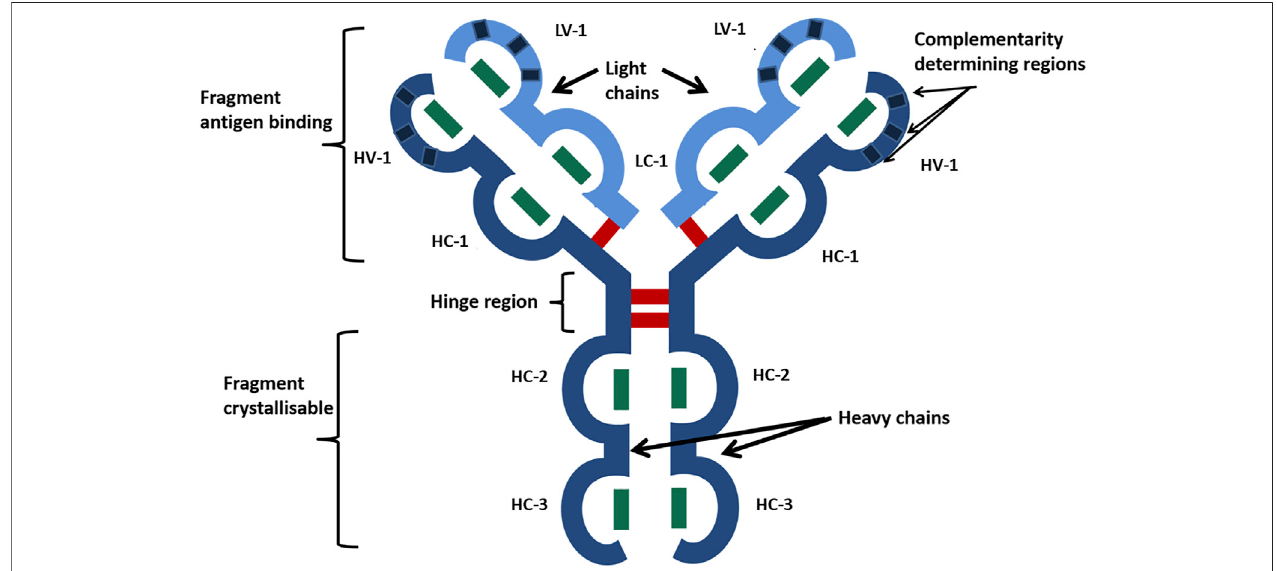
FIGURE 1 | Schematic of the IgG1 mAb characteristic Y-shaped structure. Heavy chains are shown in dark blue, and light chains in are shown light blue. Ig-like domains are represented as bulges in the linear protein sequence and are named HV, heavy variable; HC, heavy constant; LV, light variable; and LC, light constant. Disul fi de bonds are represented bybars, with green being disul fi de bonds buried withinIg domains and red being exposed interchain disul fi de bonds. Reproduced with permission from Gurjar et al., 2019.